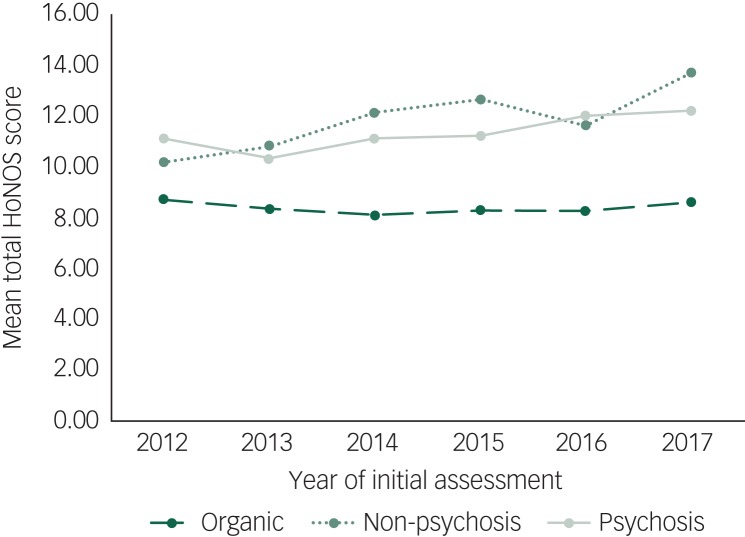
Mean total Health of the Nation Outcomes Scales (HoNOS) score at initial assessment against year of initial assessment for the three different diagnostic clusters.